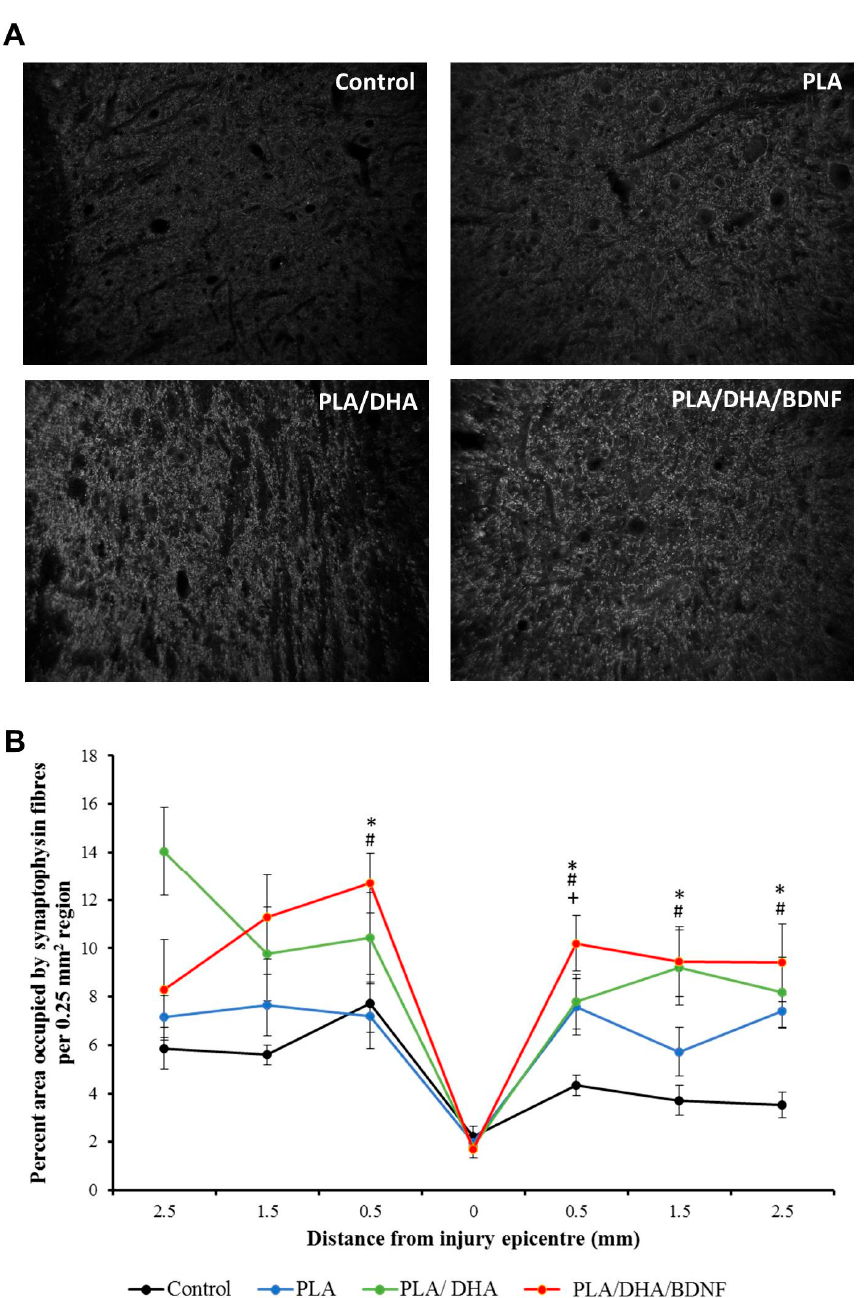
Figure 12. The immunolabeling of synaptophysin from the spinal cords of SCI rats after different treatments ( A ), and the area percentage occupied by the synaptophysin fibers in the region rostral and caudal to the injury site ( B ). * p < 0.05 represents PLA/DHA/BDNF vs. control; # p < 0.05 PLA/DHA/BDNF vs. PLA; + p < 0.05 PLA/DHA/BDNF vs. PLA/DHA.